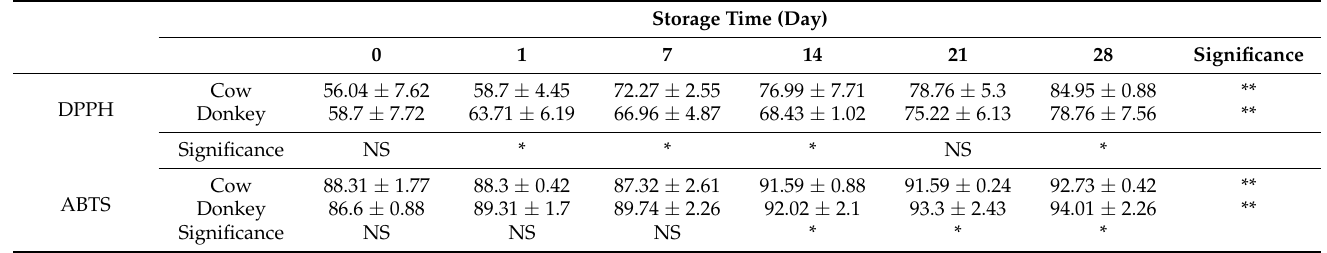
Table 3. Free radical scavenging activity of cow and donkey kefir during storage at 4 ◦ C. Storage Time (Day)